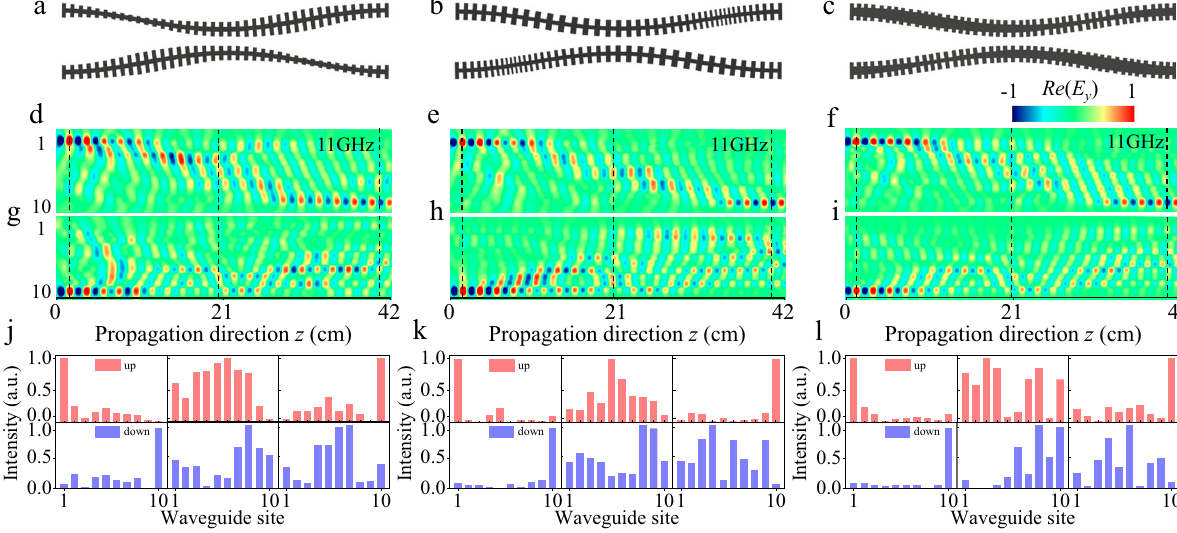
Fig. 3 Experimental observation of asymmetric topological pumping. Three types of photonic-lattice con fi gurations are considered, including engineering of height, period, and girder width pro fi les of the “ H-shaped ” structures in ultra-thin corrugated metallic coupled waveguide arrays. Schematic of altering a height, b period, and c girder width. d – f Near- fi eld evolution of the measured electric fi eld E y at the excited frequency 11 GHz from the 1st site shows the openness of the pump channel. g – i Near- fi eld evolution of the measured E y from the 10th site show the disability of the pumping. Correspondingly, the two upper and lower panels in j , k , and l show the instantaneous fi eld distributions at the propagation distances z = 0, 21, 42 cm, as shown by the black dotted lines in d – i , respectively, which are regarded as the chosen phase ϕ in one driven period equals to 0, π , and 2 π ,